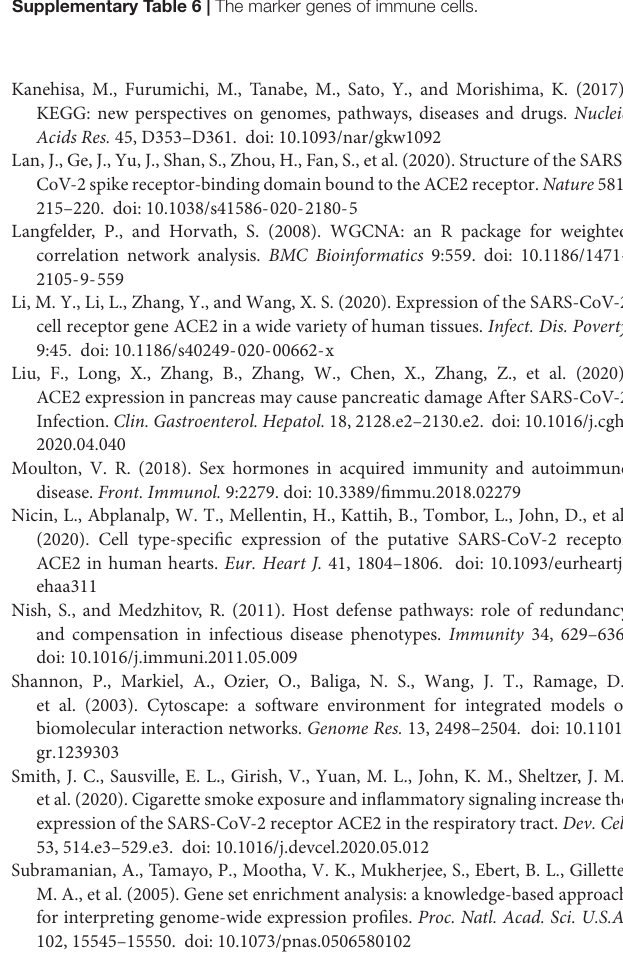
Supplementary Table 1 | The list of genes showing a significant expression correlation with ACE2 in pan-tissue. Supplementary Table 2 | The list of genes showing a significant expression correlation with ACE2 in female pan-tissue. Supplementary Table 3 | The list of genes showing a significant expression correlation with ACE2 in male pan-tissue. Supplementary Table 4 | 77 genes showing a significant positive expression correlation with ACE2 in females (Pearson correlation coefficient, r > 0.5) but a negative expression correlation with ACE2 in males ( r < 0). Supplementary Table 5 | A summary of the datasets used in this study. Supplementary Table 6 | The marker genes of immune